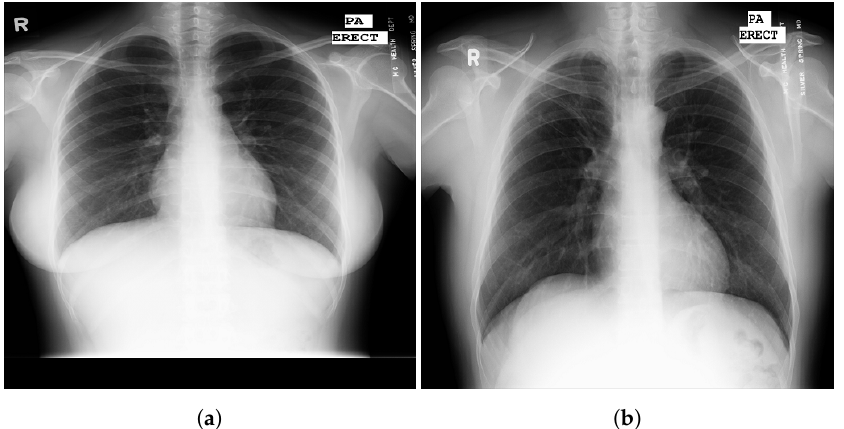
Figure 10. Examples of MONTGOMERY images. ( a ) Normal patient; ( b ) patient with tuberculosis [33].